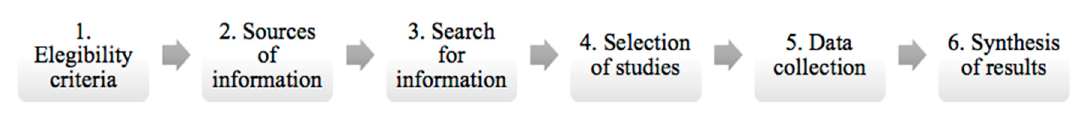
Figure 1. Steps for a systematic review of literature.